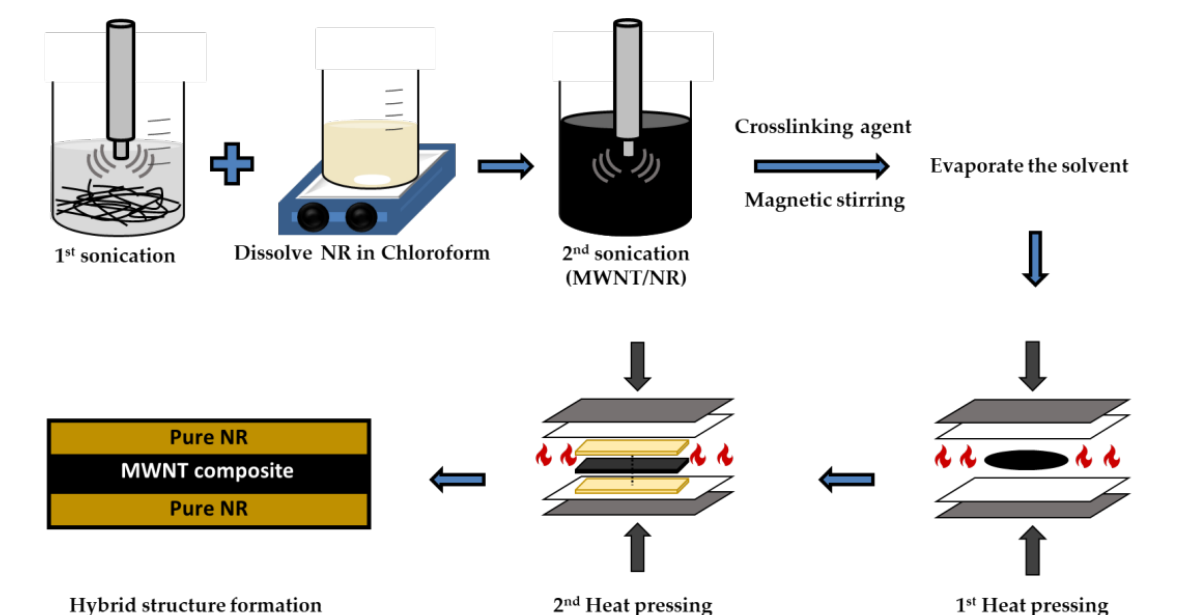
Figure 1. Scheme of the fabrication method of the MWNT/NR single composite and the MWNT/NR hybrid structure.